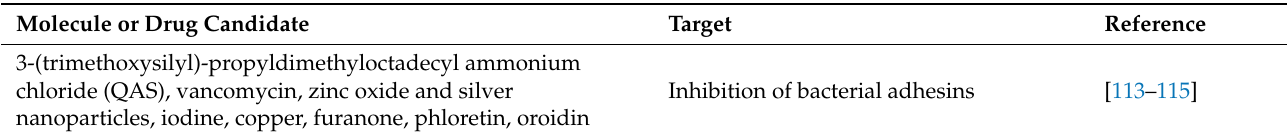
Table 1. Potential small molecules and drug candidates for biofilm